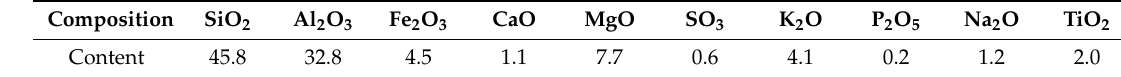
Table 1. Components of coal gangue /